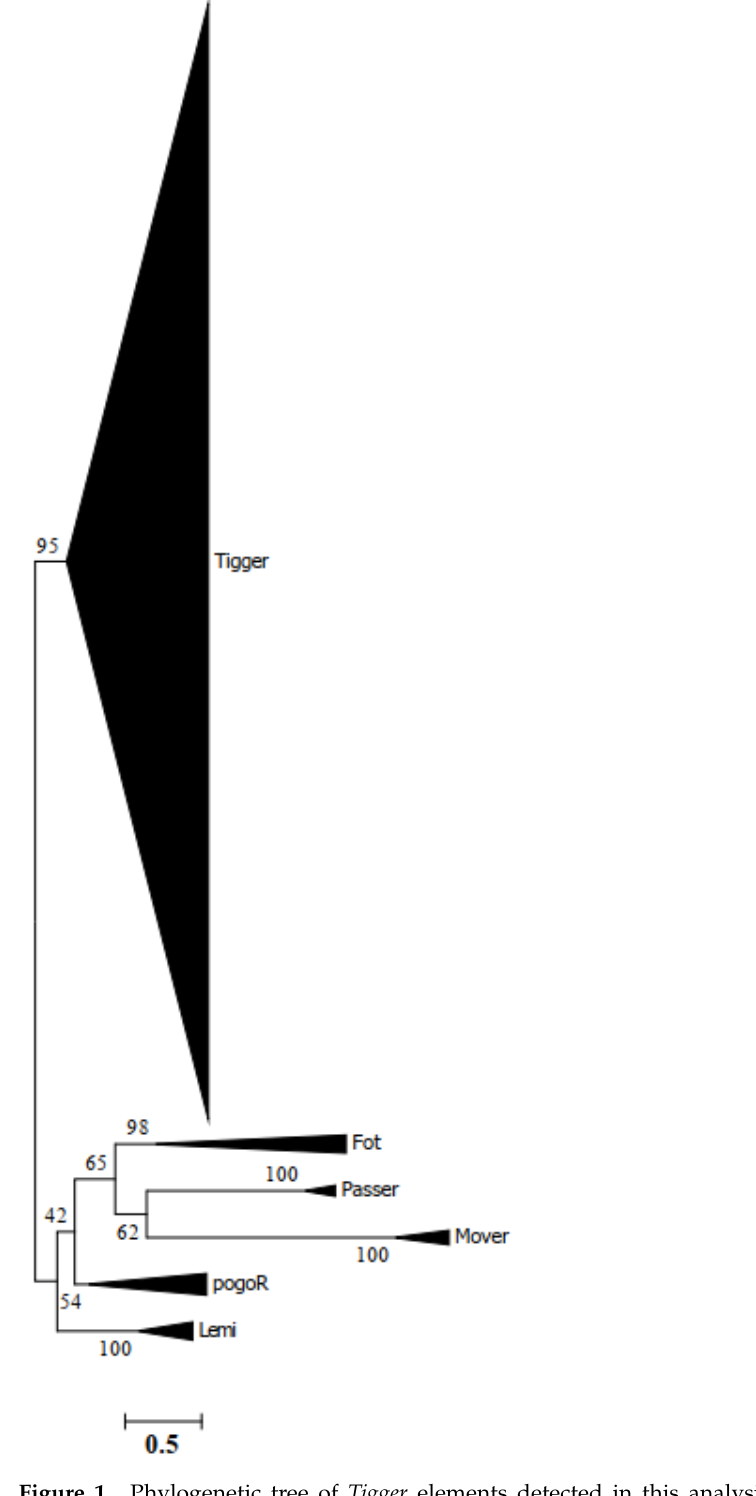
Figure 1. Phylogenetic tree of Tigger elements detected in this analysis with five other members of the pogo superfamily ( Passer , Mover , Fot/Fot-like , pogoR , and Lemi ) based on transposases. In IQ-TREE, bootstrapped (1000 repetitions) phylogenetic trees were inferred using the maximum-likelihood approach.